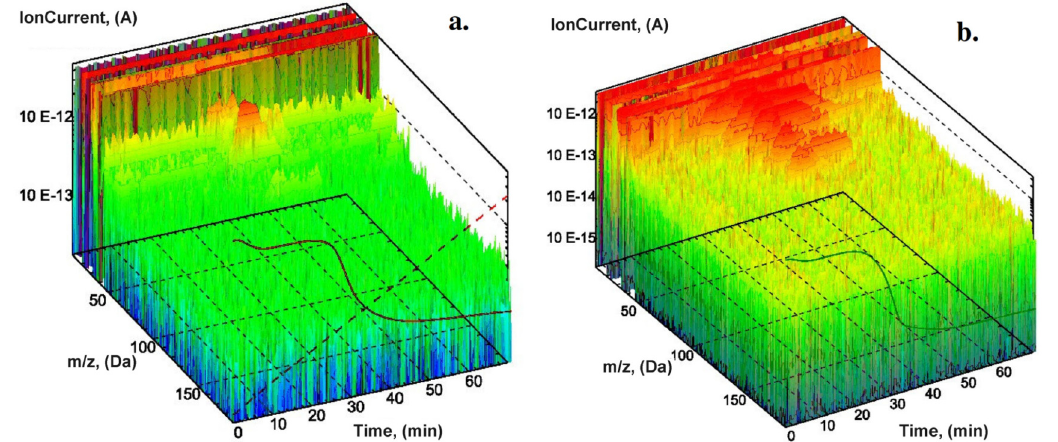
Figure 4. 3D representation of TGA-MS analysis results. (a) Fragments resulted during thermal degradation of collagen gel; (b) Fragments evolved during degradation of collagen gel/BC